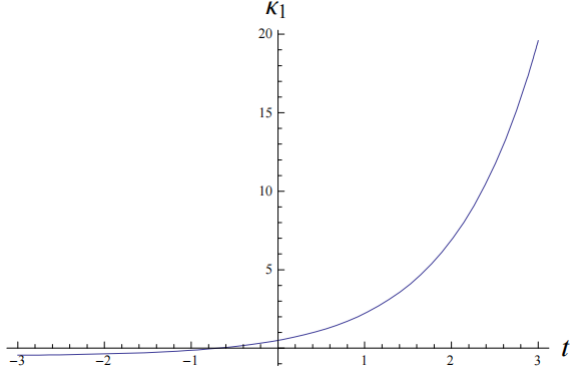
Figure 4. Nonlinear dynamical evolution of the spectrum κ 1 in Equation (122).